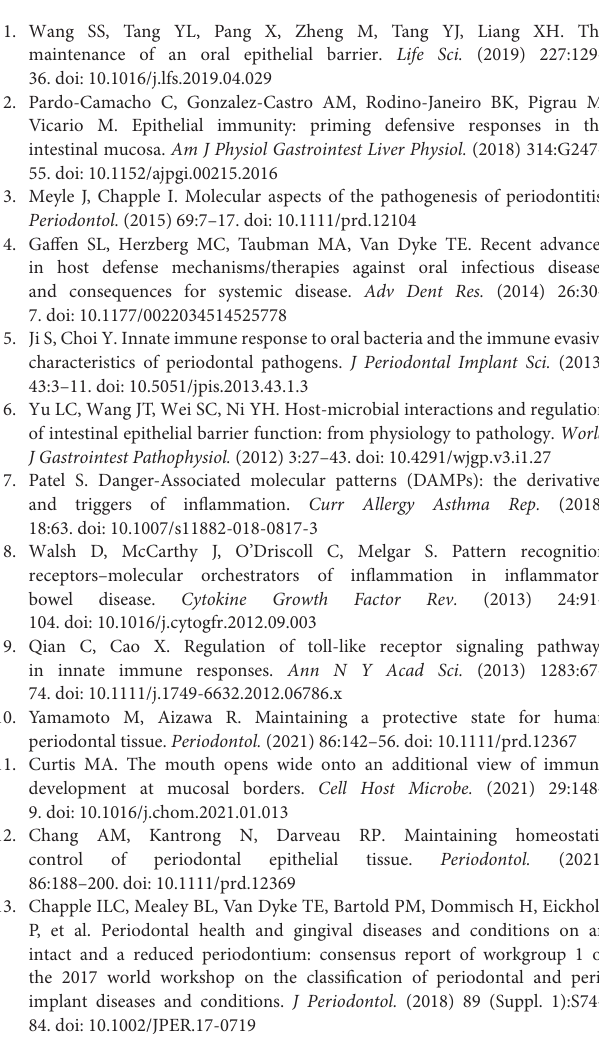
mean normalized signal level for each age group of healthy [Adult (ADU), Aged (AG)] or periodontitis [Adult-periodontitis (ADU-PD), Aged-periodontitis (AG-PD)] animals. The genes are stratified into general functional categories (ECM Structural; ECM remodeling; Cytoskeleton Regulation; Junction Associated; Cell Adhesion; Growth Factors; Cell Surface Receptors; Kinases; Transcription Factors; Antimicrobial Peptides; Inflammatory Responses) and grouped in the graphs in alphabetical order. Supplementary Figure 2 | Z-score normalization and heatmap of the array of epithelial gene expression patterns in individual animals in healthy or periodontitis tissues. Supplementary Figure 3 | (A–R) Normalized gene expression levels in gingival tissues reflecting epithelium/epithelial cell functions. The points represent the mean normalized signal level for each age group of healthy (ADU, AG) or periodontitis (ADU-PD, AG-PD) animals. The genes are stratified into general functional categories and grouped as in Supplementary Figure 1 . Supplementary Table 1 | Panther pathway analysis of altered gene expression patterns that were over-represented within the epithelial cell biology using M. mulatta as the reference